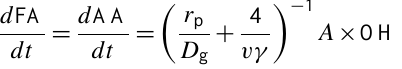
Fig. 11. A diffuse source of FA from aerosol aging (dominated by biomass burning (R3)) allows the model to reproduce the increase in FA during the biomass burning season in La R´eunion (a) and Wollongong (b) . Color code as Fig.